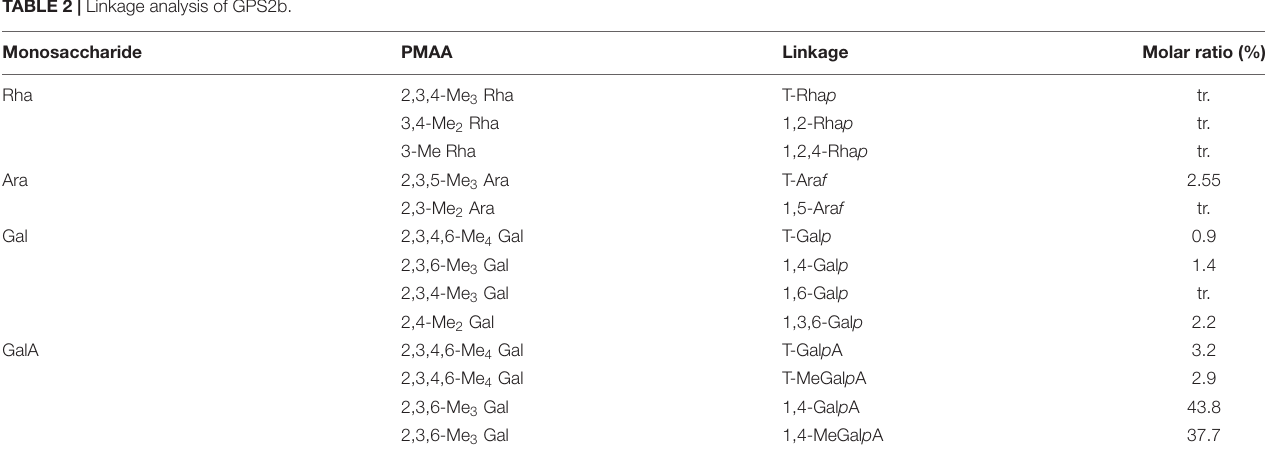
FIGURE 3 | Deuterium labeling of galacturonic acid (GalA) and methyl-esterified GalA during a two-step reduction procedure, reprinted with the permission from Springer Nature (25). TABLE 2 | Linkage analysis of